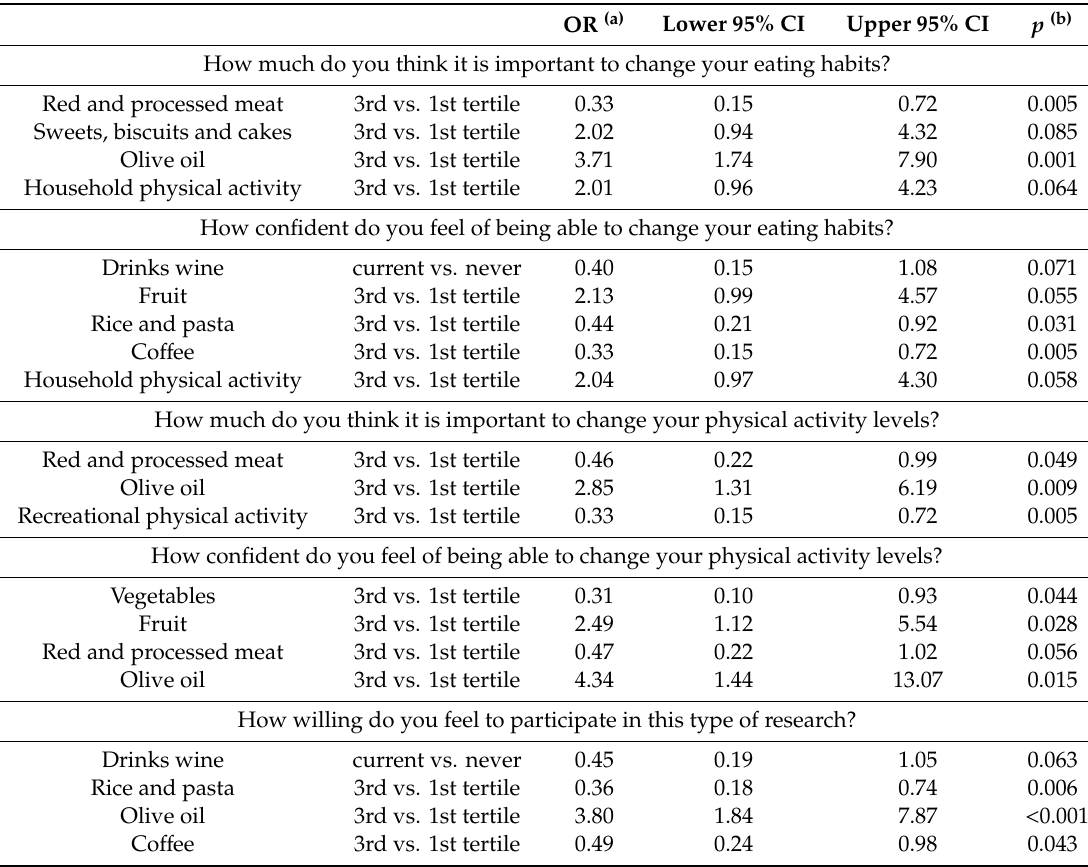
Table 1. Factors associated with the odds of being in the upper vs. lower half of the distribution of scores given to each question of the baseline motivation questionnaire in the diet, physical activity and mammography trial. Florence, Italy, 2009–2012. OR (a) Lower 95% CI Upper 95%